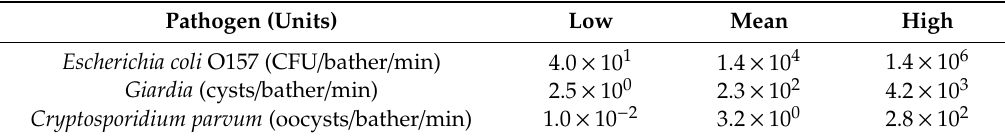
Table 6. Initial pathogen shedding rate.